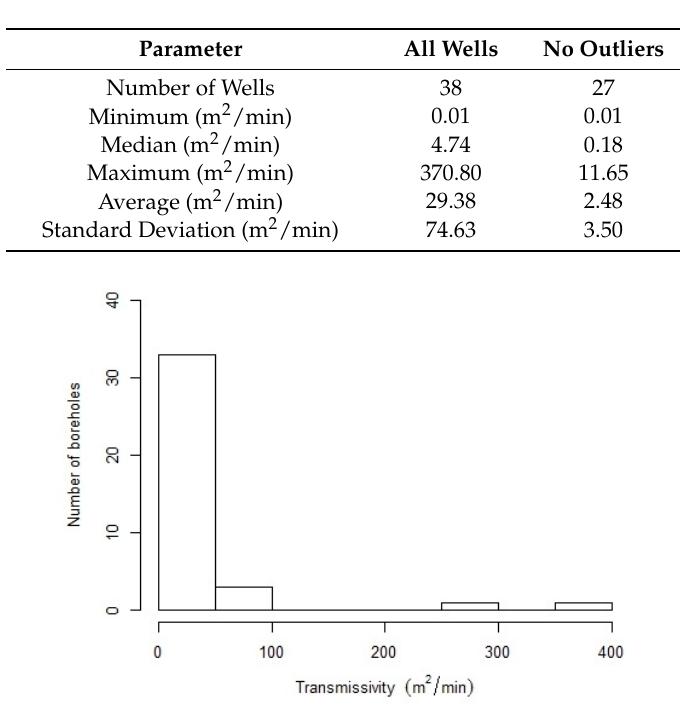
Figure 4. Pumping test-derived aquifer T values related to ( a ) borehole depth, ( b ) aquifer thickness, ( c ) borehole elevation, and ( d ) aquifer hydraulic conductivity, from 27 boreholes (all located in 1KB17 catchment) with no outliers in aquifer T values. 3.2. Regional-Scale T Estimates from Streamflow Table 4 shows the statistical summary of K values estimated across three catchments (namely, 1KB17, 1KB14 and 1KB4) in the Kilombero Valley for both dry and wet seasons. For the smaller two catchments (1KB14 and 1KB4), the dry season K values were higher than those estimated from wet season events. For the larger 1KB17 catchment, which drains the valley floor and wetland, the dry season K value was lower than that estimated using wet season events (Table 4). For the smallest (1KB14) and the largest (1KB17) catchments, these results were consistent with a previous analysis